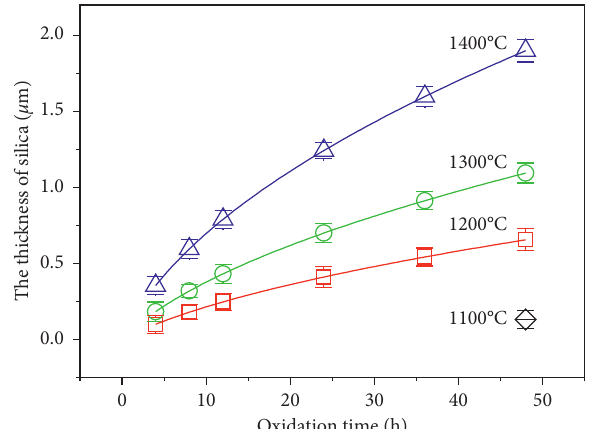
Figure 6: The thickness of the silica layer as a function of oxidation time under different temperatures in air atmosphere.